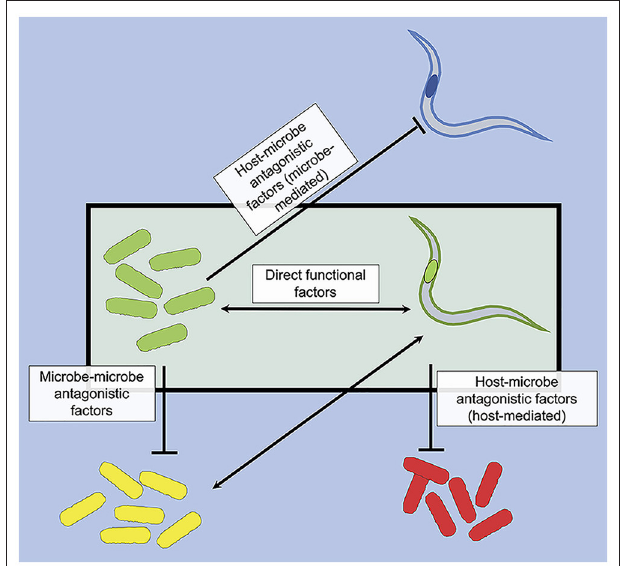
FIGURE 3 | Strain specificity factors in host-symbiont associations can drive selection for specific host-symbiont associations (boxed) through positive selection (direct functional factors) and negative selection (antagonistic factors). Strain-specific association is indicated by matching color in microbes and